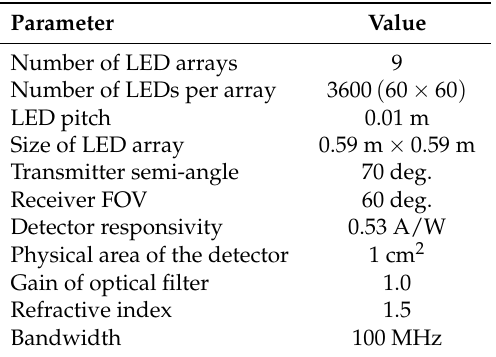
Figure 3. The room model. The room size was 7.5 m × 7.5 m × 3 m. The height of the receiver was 0.7 m from the floor. The height of LED arrays was 3 m from the floor [16]. Table 1. Parameters of the MU-MISOindoor VLC